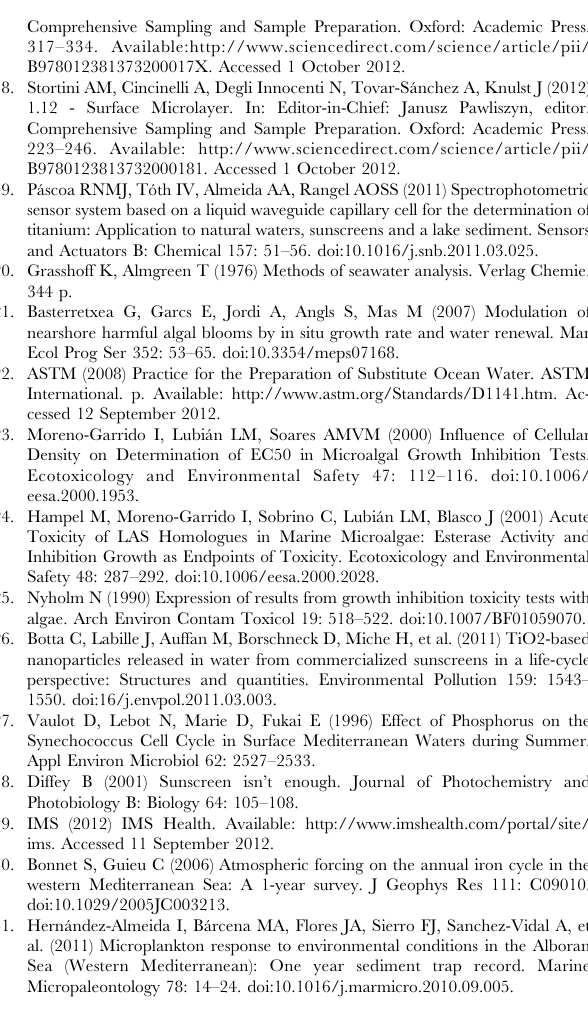
Figure S1 Modeled variations of PO 43 2 ( m M) at Palmira Beach (Majorca) estimated from sinusoidal variations of beachgoers and 6 hours averaged current velocities. Dashed line indicates shelf water background concentration. (TIF) Figure S2 Diel variation of beach users at Palmira during a labor day (bars) and sinusoidal adjustment used in model simulations (line). (TIF)